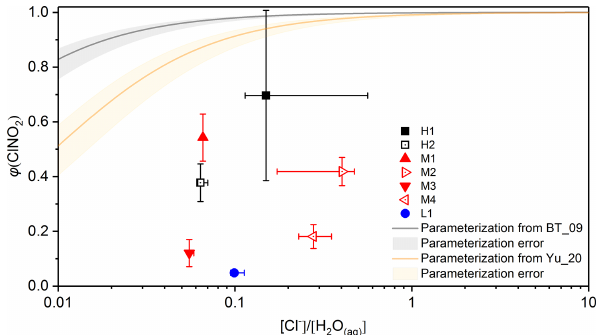
Figure 7. Measured and calculated values of ϕ (ClNO 2 ) at 75% ± 2% RH as a function of [ Cl − ] / [ H 2 O (aq) ] . Black and orange curves represent ϕ (ClNO 2 ) calculated using the BT_09 parameterization (Bertram and Thornton, 2009) and the Yu_20 parameterization (Yu et al., 2020), and the associated errors are represented by the corre- sponding